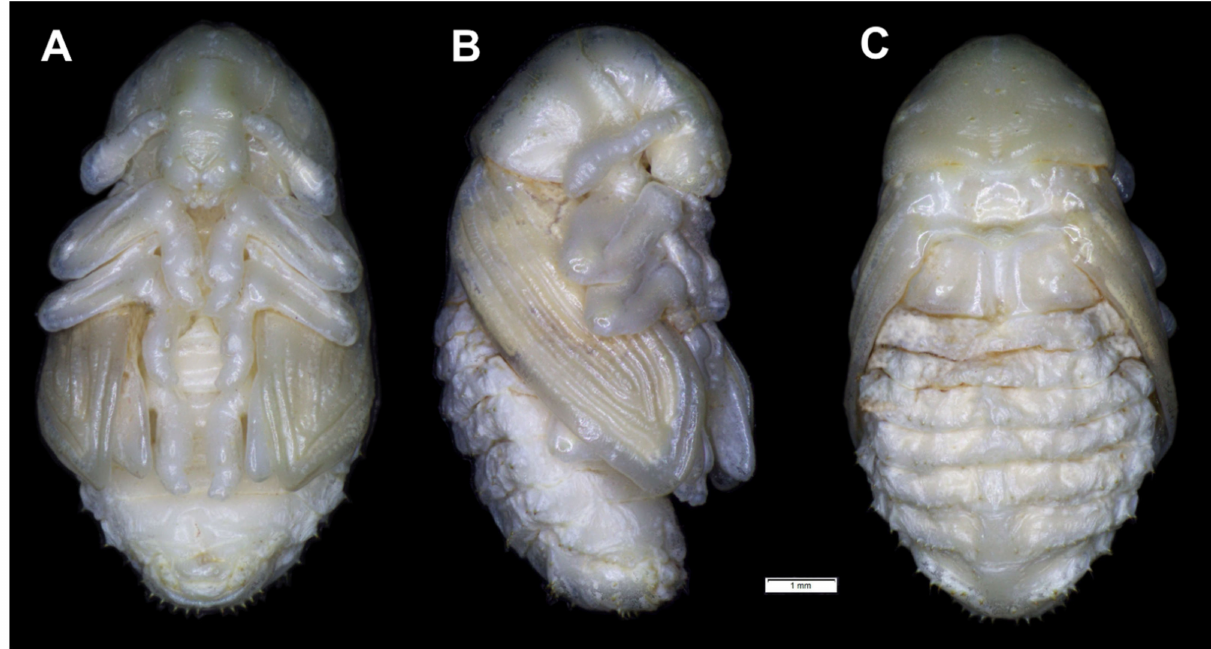
Figure 19. Rhinocyllus alpinus habitus of pupa. ( A )—ventral view; ( B )—lateral view; ( C )—dorsal view. Chaetotaxy visible, with setae of various lengths from medium to short on